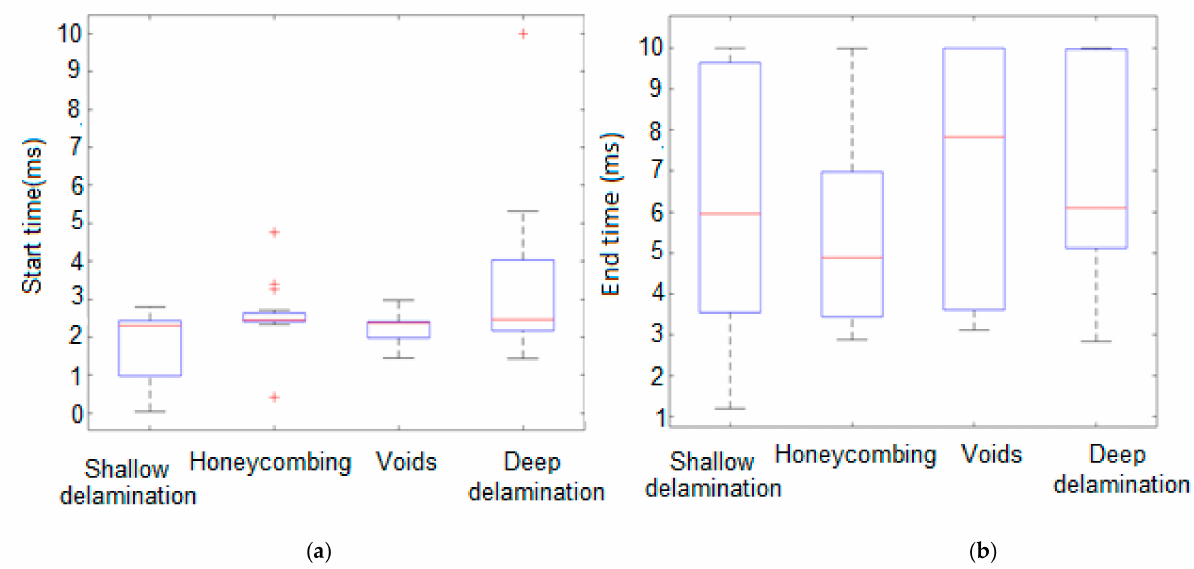
Figure 10. Box plot for the end time of the preprocessed IE signals collected from artificial defects’ ( a ) start time, ( b ) end time.